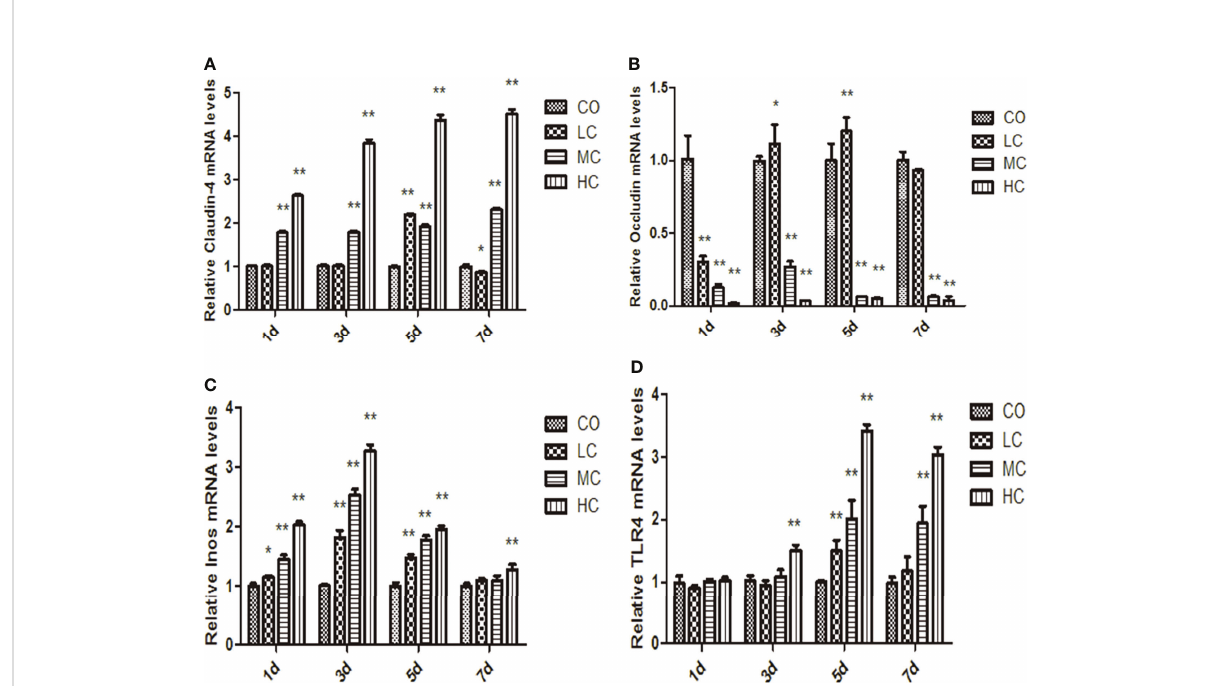
FIGURE 4 The mRNA levels of claudin-4, occludin, iNos, and TLR4 in the small intestine at different times after intraperitoneal injection of different dose of C. malonation LPS for 1, 3, 5, and 7 days. (A) claudin-4; (B) occludin; (C) iNos; (D) TLR4; * p < 0.05 compared to control (CO); ** p < 0.001 compared to CO. LC, low concentration; MC, moderate concentration; HC, high concentration; iNOS, nitric oxide synthase; TLR4, Toll-like receptor 4.